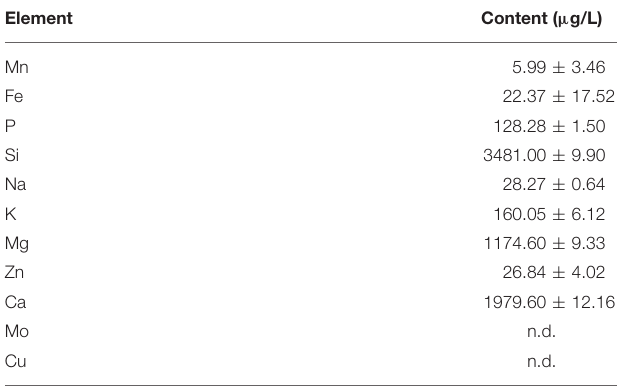
TABLE 1 | The quality of mountain spring water for microalgae outdoor cultivation.